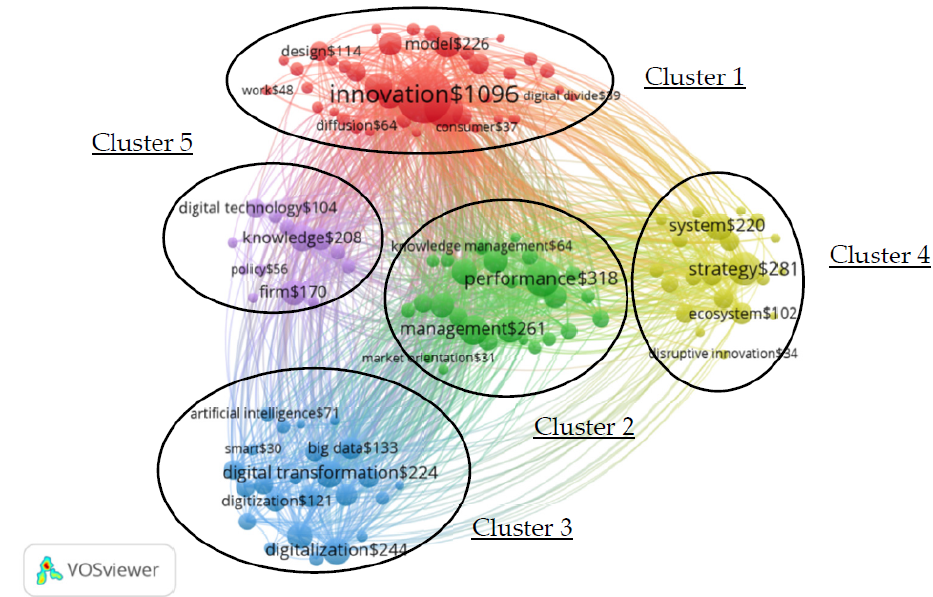
Figure 3. Clusters of keywords identified in the digital transformation and innovation research.